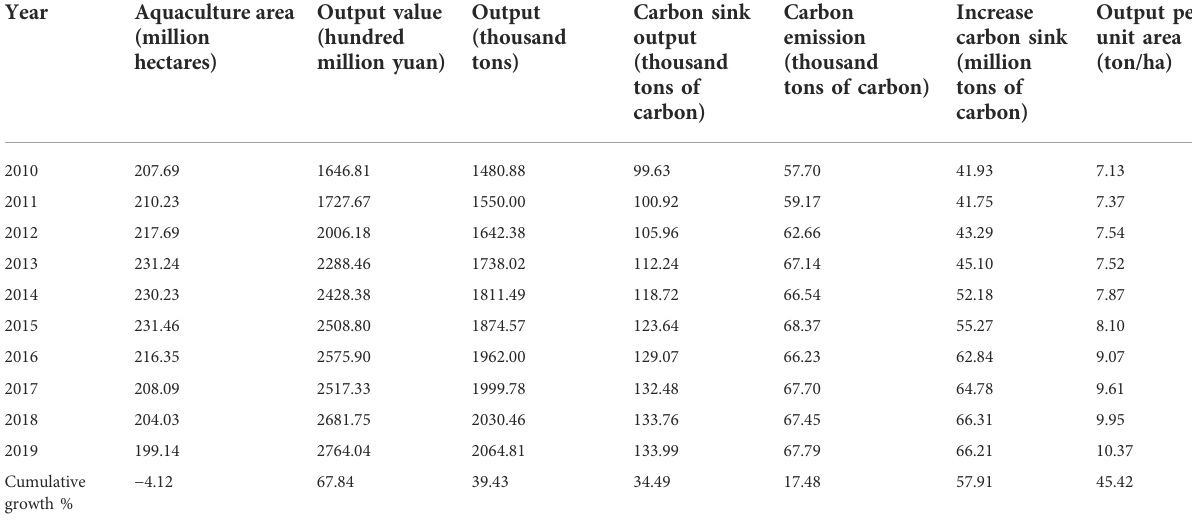
TABLE 2 Overview of the development of marine aquaculture in China from 2010 to